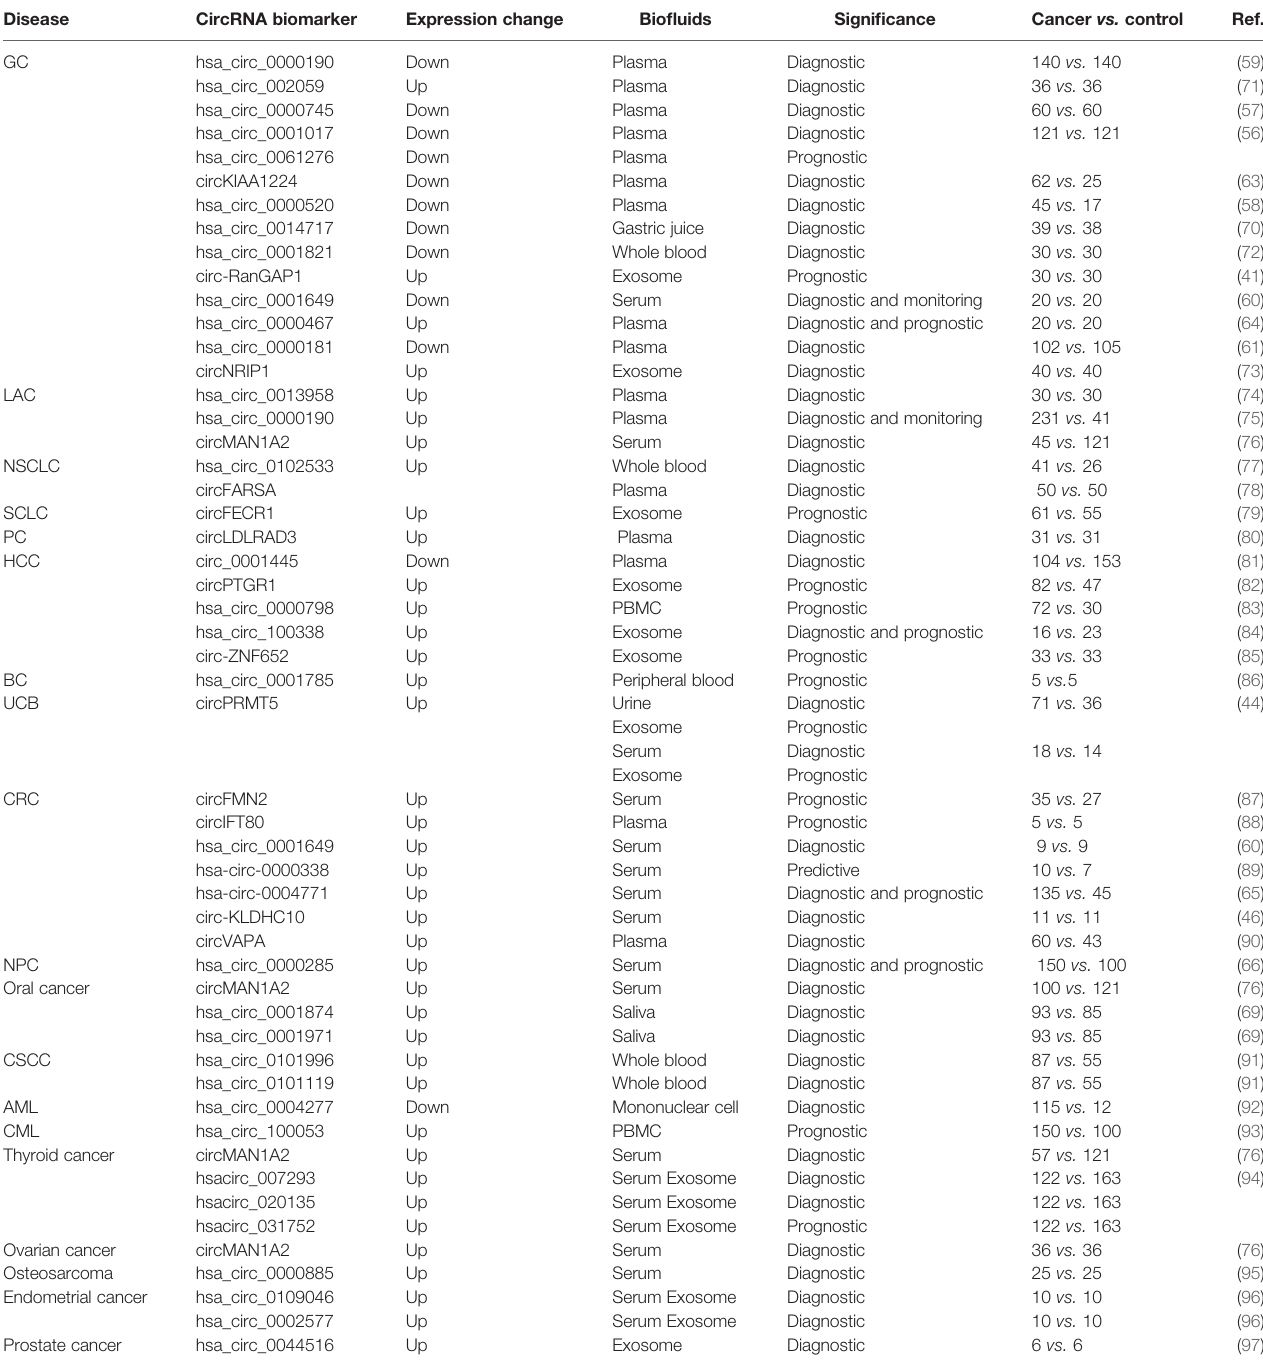
TABLE 1 | Studies of circRNA as liquid biopsy cancer